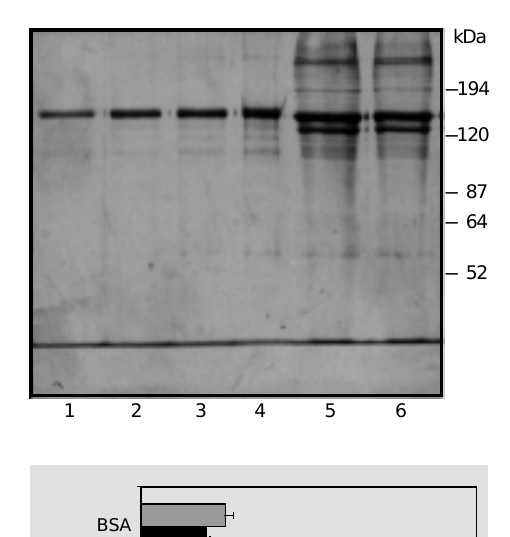
Figure 5 - Binding of S. schenckii conidia (gray bars) and yeast cells (black bars) to immobilized type II collagen at 10 µg/ml in com- parison with the adhesion ob- served to BSA. Values were sub- tracted from the negative con- trol (poly-HEMA). S. schenckii adhesion (10 7 cells/well) was as- sessed by ELISA with an anti- S. schenckii antiserum. *P<0.05 compared to BSA (Student t